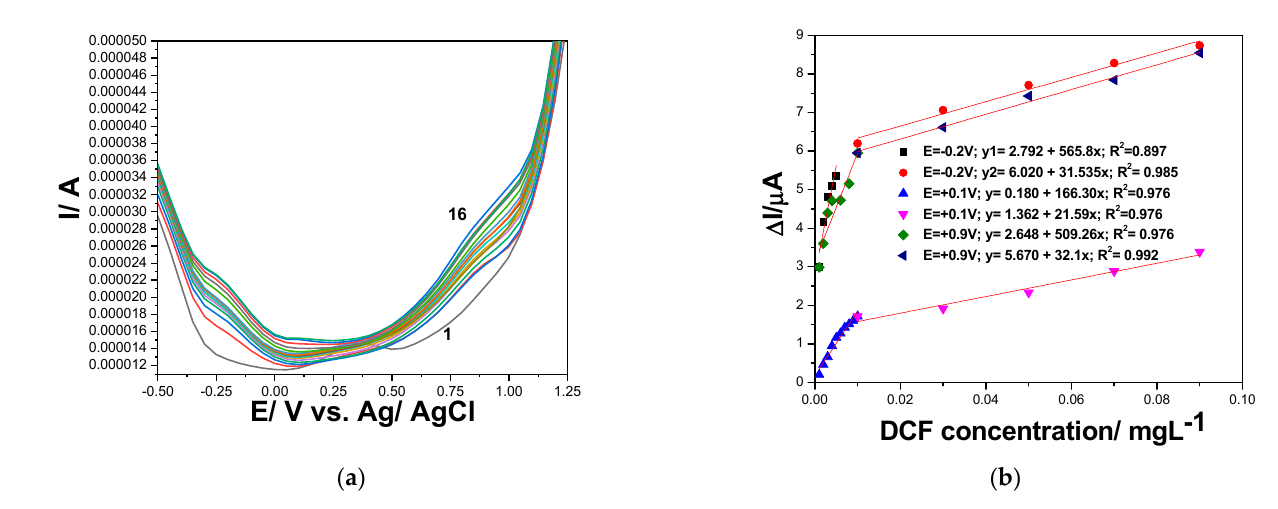
Figure 5. ( a ) Differential-pulsed voltammograms at GR-CNT electrode in 0.100 M Na 2 SO 4 supporting electrolyte (curve 1) and in the presence of different DCF concentrations: curves 2–16: 0.001–0.110 mgL − 1 DCF; 50 mV step potential; 200 mV modulation amplitude, 100 mV·s − 1 potential scan rate; potential range: − 0.500 to +1.50 V vs. Ag/AgCl. ( b ) Calibration plots of the currents recorded at E = − 0.200 V; +0.100 V and +0.900 V vs. Ag/AgCl, versus DCF concentrations. SWV was also tested for DCF detection due to its fast response. The optimized oper- ating conditions found for DPV were tested at different frequencies, and the best perfor- Table 5. The electroanalytical parameters for diclofenac detection with GR-CNT paste electrode in mance was achieved for the frequency of 2 Hz at the scan rate of 100 mVs − 1 . Figure 6a 0.100 M Na 2 SO 4 supporting shows the SWV measurements of DCF oxidation at various concentrations from 1 to 10